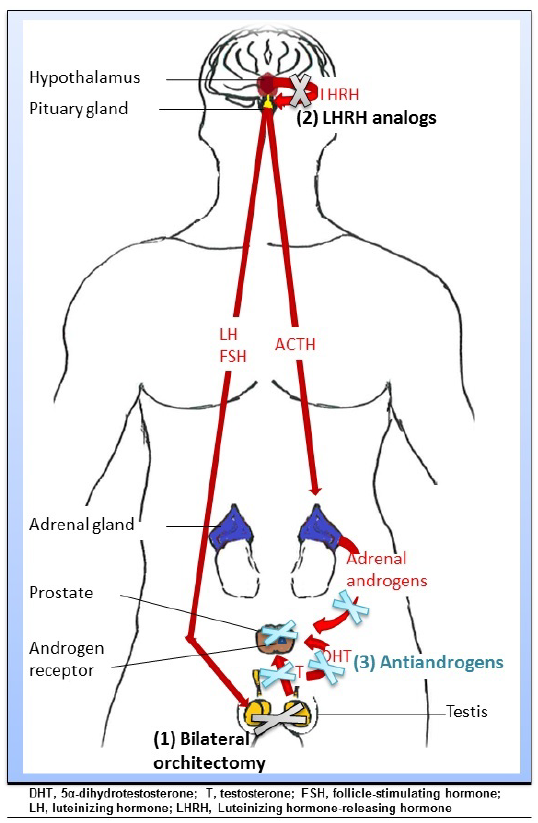
Figure 1. Mechanisms of action of androgen deprivation therapy (ADT) for blockage of the hypothalamus-pituary